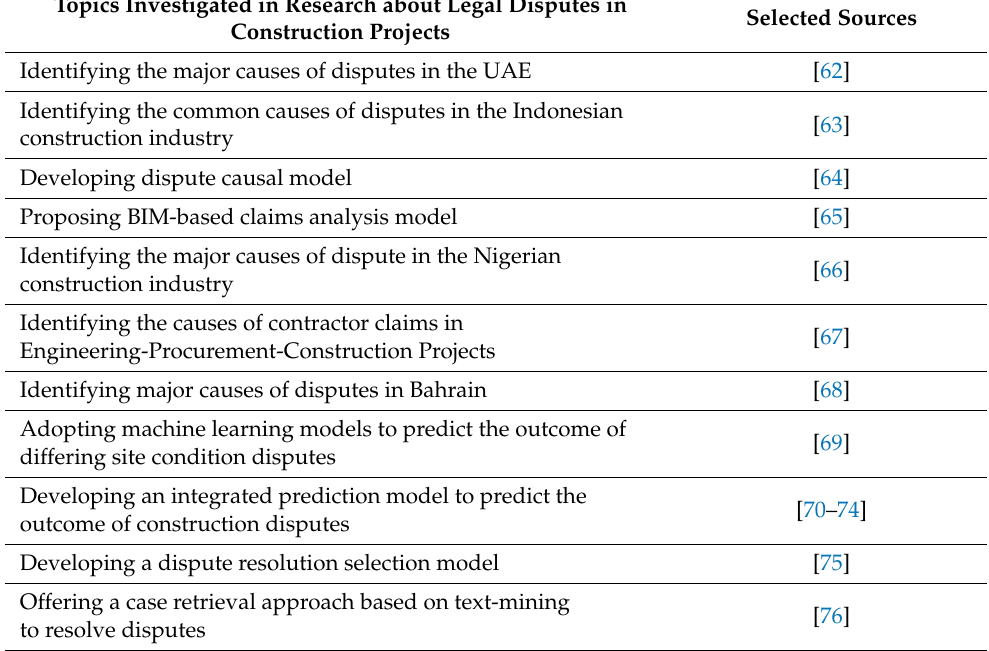
Table 3. Research About Construction